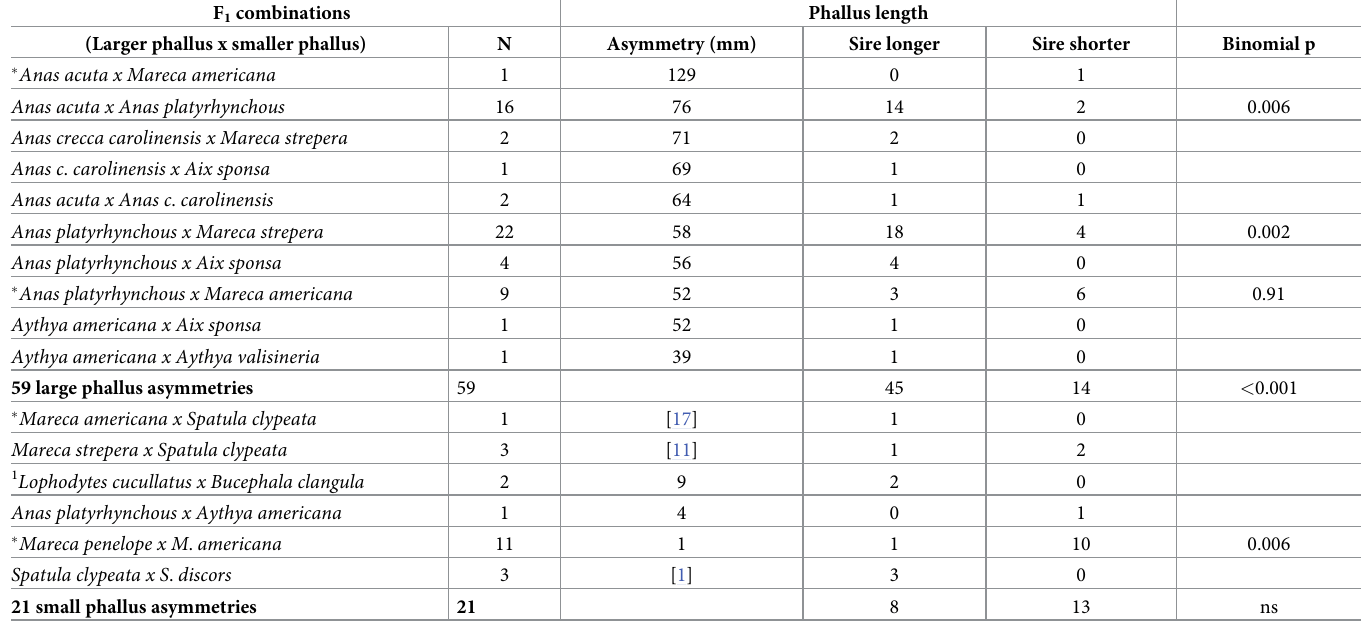
Although samples are smaller two other parental combinations in the top portion of Table 1 support the phallus asymmetry prediction. The four A . platyrhynchos x Aix sponsa (Mallard x Wood Duck), and the single Aythya americana x Aix sponsa (Redhead x Wood Duck) F s were all sired by the larger species, which also has the larger phallus. Additionally, 1 males of species characterized by large phalluses were much more likely to sire hybrids than expected by chance encounters estimated from density of parentals in areas of sympatry (Fig 1). Thus, the two largest deviations from expected frequencies were for hybrids of Anas platyr- hynchos x Mareca strepera and Anas acuta x A . platyrhynchos (Table 1; Fig 1). These results are particularly compelling because our hunter-shot samples were more or less randomly collected. Across species, the comparative evidence that forced copulations generate F hybrids in 1 temperate ducks is compromised by small samples for most parental combinations. Just 10 parental combinations in the upper portion of Table 1 are available for a comparative test and samples of 4 or fewer. Of the 10 parental combinations, forced 7 of these combinations have F 1 Table 1. Phallus asymmetries and sires for 80 F 1 hybrids ducks taken in North America organized by species differences in phallus length. Mean phallus lengths are based on winter adults. For each hybrid combination the first listed species has the larger phallus. The upper section of this table lists hybrid combinations with large and reliable phallus asymmetries; the lower section lists small asymmetries that are unlikely to be predictive. F 1